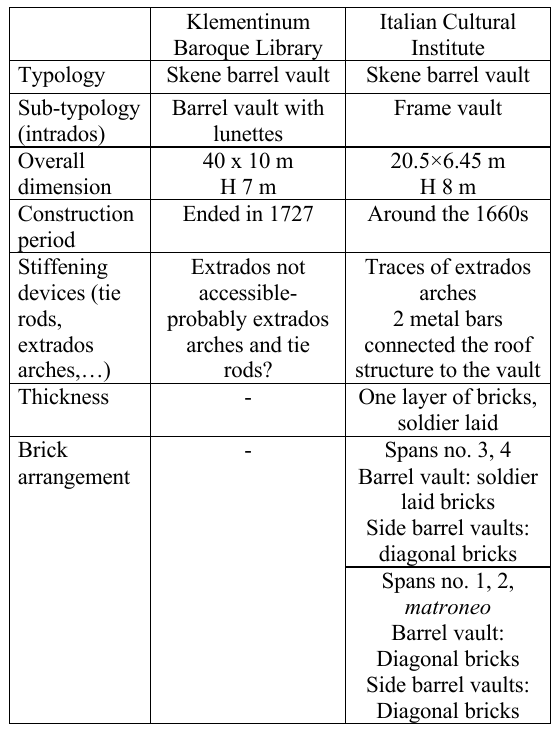
Table 1. First information for the database of the